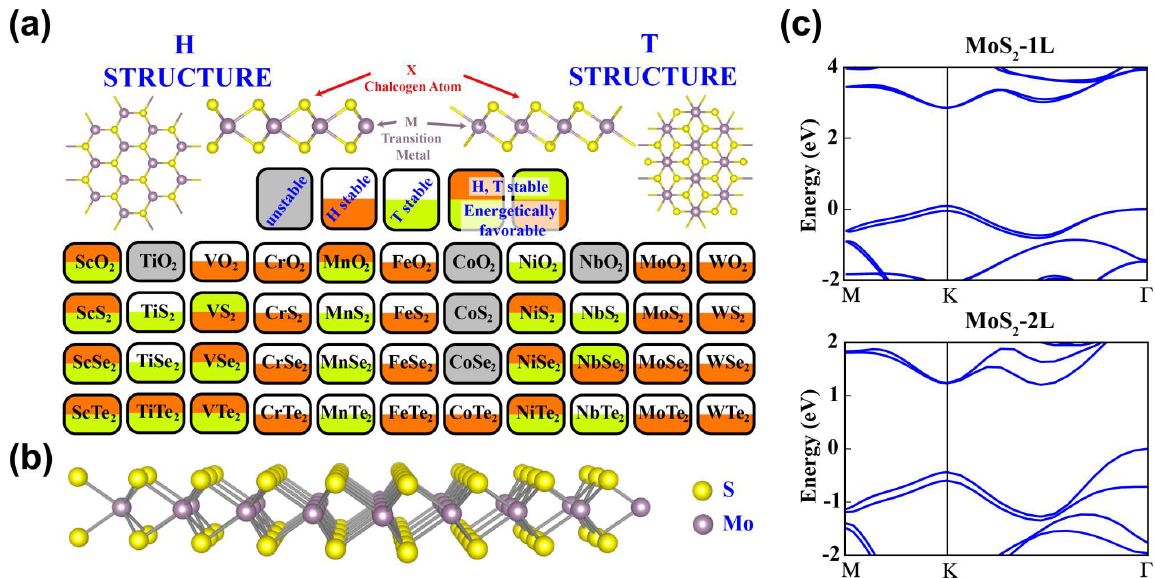
Figure 1: TMD monolayers with formula MX 2 , where M is a transition metal of group 4–10 and and X is a chalcogen (or oxygen). The mono- layers are classified according to their stability in the H or T structures, where H is the most common structure with D 3 h symmetry and trig- onal prismatic metal coordination, and T indicates a structure with D 3 d symmetry and octahedral metal coordination (see Ref. 26). Unstable structures are shown in gray. (b) The structure of monolayer MoS 2 , shared by the other group-6 TMDs. (c) Band structure of monolayer and bilayer MoS 2 , computed using DFT plus GW. The band structures of MoSe 2 , WS 2 , and WSe 2 are qualitatively similar to the ones of MoS 2 shown